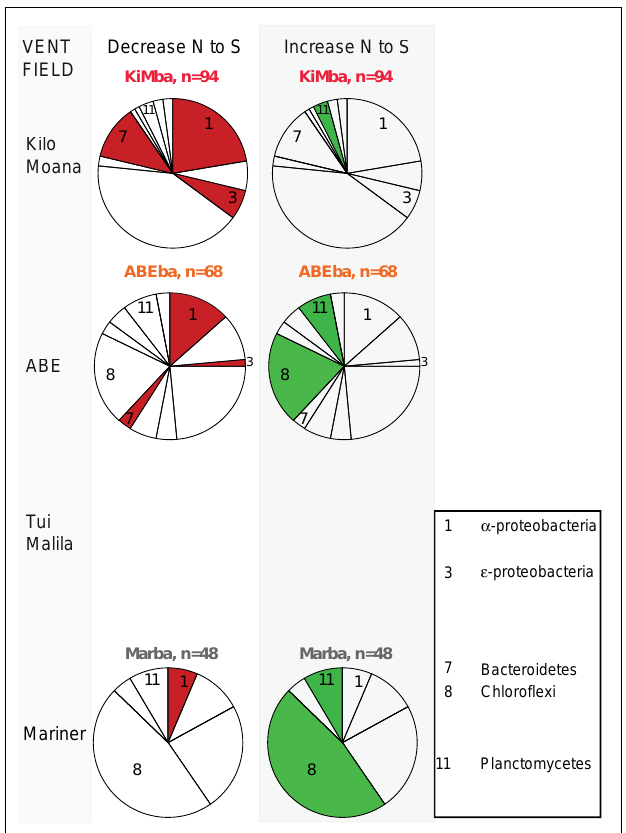
FIGUREA2 | Bacterial distributions of phyla/classes that either decrease (left column) or increase (right column) in proportionality from north (Kilo Moana) to south (Mariner) on silicate samples in this study. Key is the same as Figure 4 , except that phyla/classes that decrease from north to south are all red, those that increase from north to south are all green, and those that do not show a north to south pattern are not